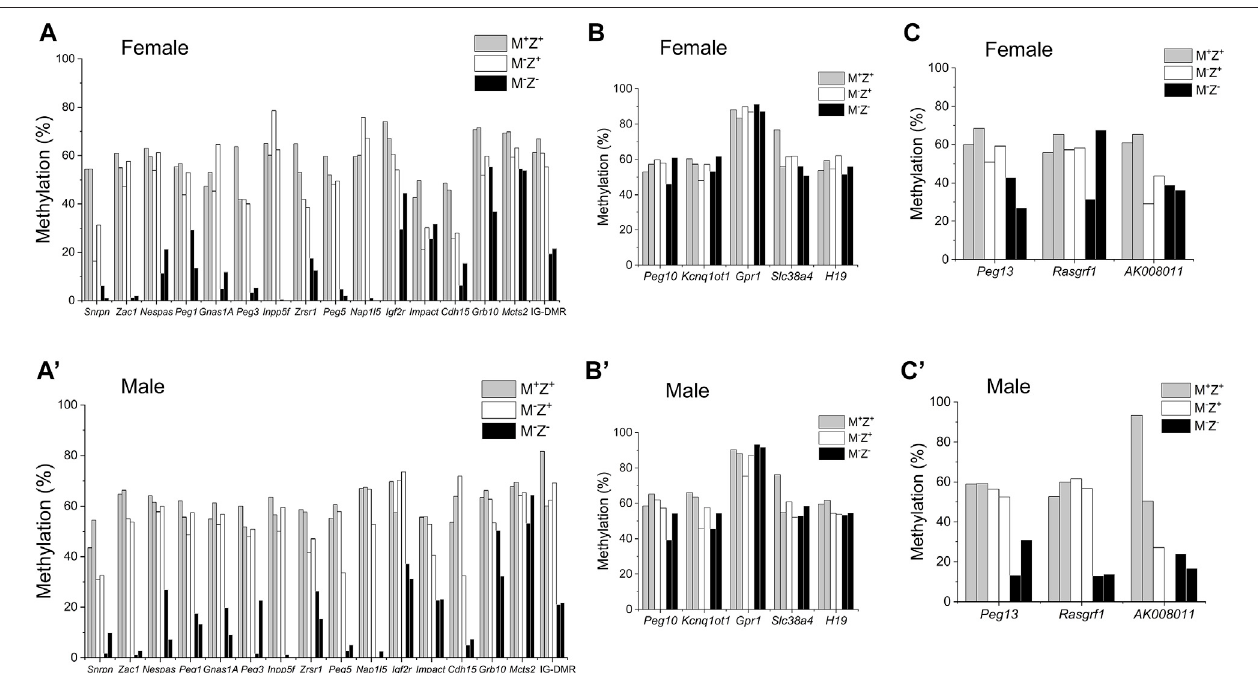
FIGURE1| DNAmethylationatthreeimprintedregionsappearedtobemoreseverelylostinmale Zfp57 maternal – zygoticmutantembryosthaninthefemaleones. GenomicDNAsampleswereisolatedfromthe Zfp57 +/ − (M + Z + ), Zfp57 − /+ (M − Z + ),and Zfp57 − / − (M − Z - )hybridE13.5embryosfromthetimedmatingbetween Zfp57 +/ − (or Zfp57 − / − ) 129 female mice and Zfp57 +/ − (DBA*) male mice mainly on the DBA/2J genetic background as reported in the previous study (Jiang et al., 2021). Two female embryos of each genotype and two male embryos of each genotype were used in this study. Whole-genome bisul fi te sequencing (WGBS) was carried out to examine DNA methylation at previously known 21 maternally methylated and three paternally methylated ICRs of the imprinted regions. (A – C) ICR methylation in the female embryos. (A ’– C ’ ) ICR methylation in the male embryos. (A,A ’ ) DNA methylation imprint appeared to be similarly affected at 16 ICRs in the female or male maternal – zygoticmutant(M − Z - )embryos.Theseincludethe Snrpn , Zac1 , Nespas , Peg1 , Gnas1A , Peg3 , Inpp5f , Zrsr1 , Peg5 , Nap1l5 , Igf2r , Impact , Cdh15 , Grb10 ,and Mcts2 ICRs as well as the IG-DMR. (B,B ’ ) DNA methylation imprint was mostly retained at the Peg10 , Kcnq1ot1 , Gpr1 , Slc38A4 , and H19 ICRs in the female or male maternal – zygotic mutant (M − Z - ) embryos. (C,C ’ ) DNA methylation imprint appeared to be more severely lost at the Peg13 , Rasgrf1 , and AK008011 ICRs in the male maternal – zygotic mutant (M − Z - ) embryos compared with the female maternal – zygotic mutant (M − Z - ) embryos. There were no sequence reads at the AK008011 ICR in the second male M − Z + embryo in (C ’ )